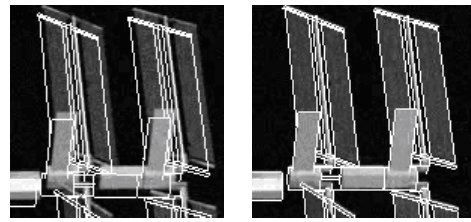
Figure 5. Zoomed-in fragments of Figure 4 and Figure 5